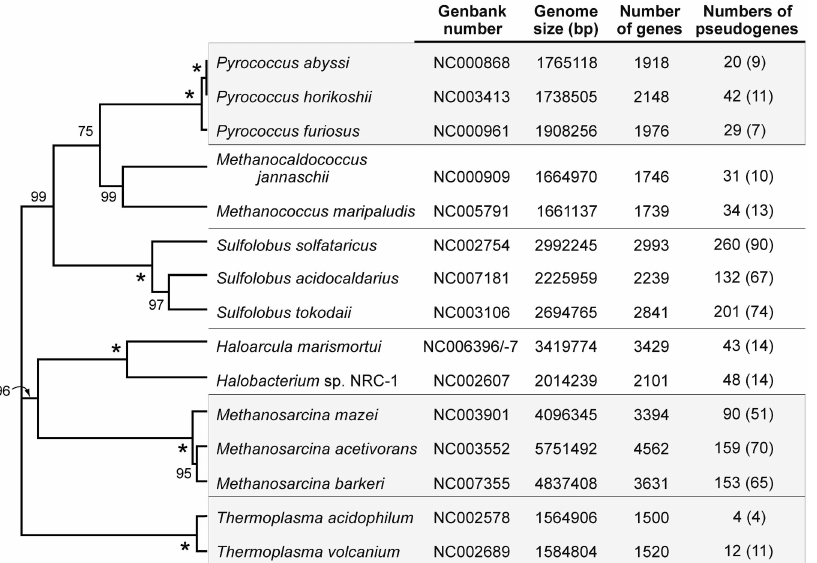
Figure 1. Relationships and features of archaeal genome sequences used in this study. Numbers at the nodes of the tree represent bootstrap values, with asterisks indicating 100% bootstrap support. The column labels indicating the numbers of pseudogenes represent total numbers, with the numbers in brackets indicating the po- sitional pseudogenes.Horizontal lines sep- arate different clades, and members within each clade were compared to detect